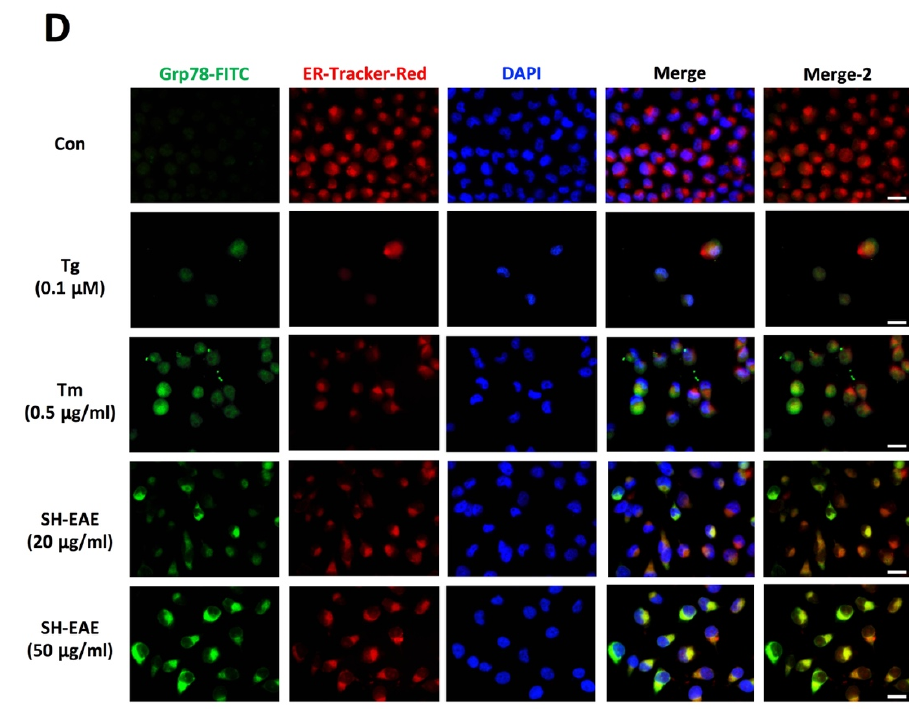
Figure 2. SH-EAE decreased both protein and mRNA expression of two ER stress sensors, PERK and IRE-1 α . ( A ) H1299 and H460 cells treated with different concentrations of SH-EAE (10, 20, and 50 µ g/mL) for 48 h. Protein lysates were collected and subjected to SDS-PAGE followed by immunoblotting using antibodies against Grp78, IRE-1 α , PERK, ATF6, Calnexin, PDI, Ero-L α , and GAPDH (loading control). ( B ) H1299 cells were treated with 20 µ g/mL SH-EAE for 0, 2, 4, 6, 8, 10, 12, and 24 h. Protein lysates were subjected to SDS-PAGE followed by immunoblotting using antibodies against PERK, IRE-1 α , CHOP, and Grp78. GAPDH served as the loading control. ( C ) Relative fold change of mRNA abundance of UPR-related genes including GRP78 , PERK , IRE1 α , and ATF6 , was measured by qPCR in NSCLC H1299 cells treated with SH-EAE (20 and 50 µ g/mL) or Tg (0.1 µ M) for 24 h. Data are shown as fold change compared with vehicle-treated cells, and represent the mean ± SD of three independent experiments. (* p < 0.05; ** p < 0.001). ( D ) SH-EAE causes the accumulation of the Grp78 within the ER. Immunofluorescence staining of endogenous Grp78 proteins. H1299 cells were treated for 48 h with SH-EAE (20 and 50 µ g/mL), Tg (0.1 µ M), and Tm (0.5 µ g/mL), respectively, followed by immunofluorescence staining using anti-Grp78 antibody and ER-Tracker Red. The nuclei were counterstained with 4’6-diamidino-2-phenylindole (DAPI). Scale bar indicates 50 µ m. Representative images of three independent experiments are shown.